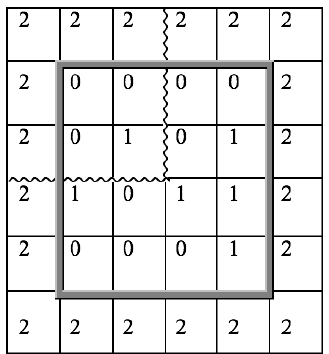
Figure 3. The urban ratio of the first non-urban cell in the upper left window was 1/3 = 0.334 (cells with 0 are non-urban, those with 1 are urban, and those with 2 represent the added outer boundary, which makes the computation